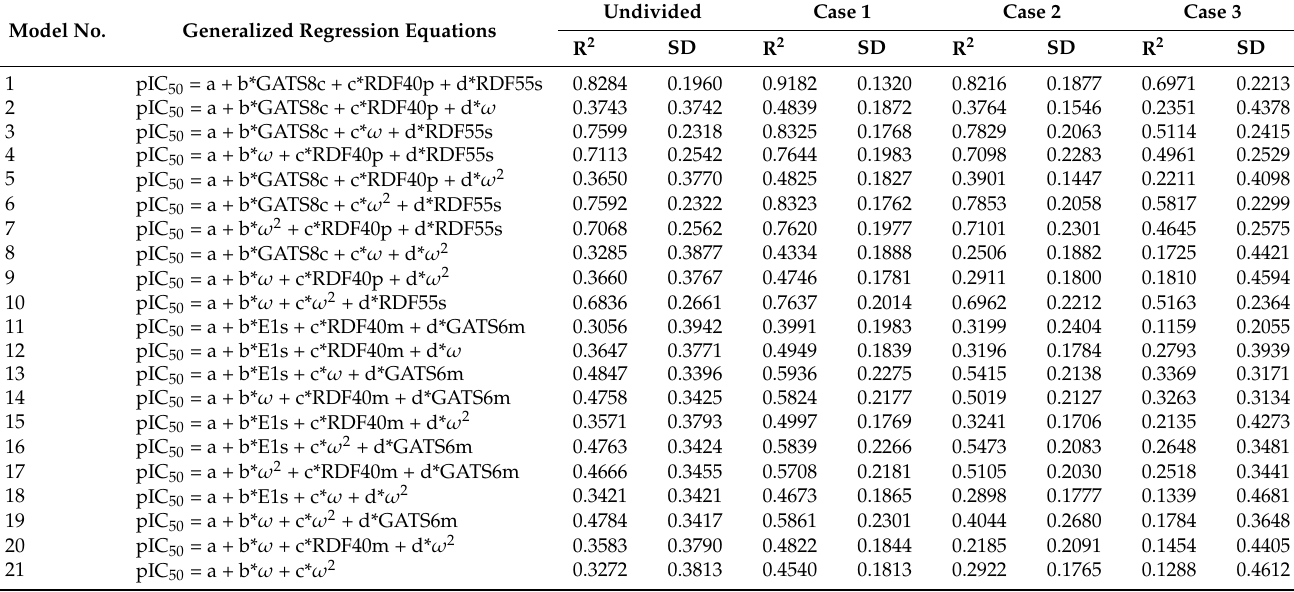
Table 2. R 2 and SD values obtained for the undivided dataset and the three combinations of training– test split in the three-fold cross-validation (reprinted from Ref. [79]. © 2019, IGI Global).